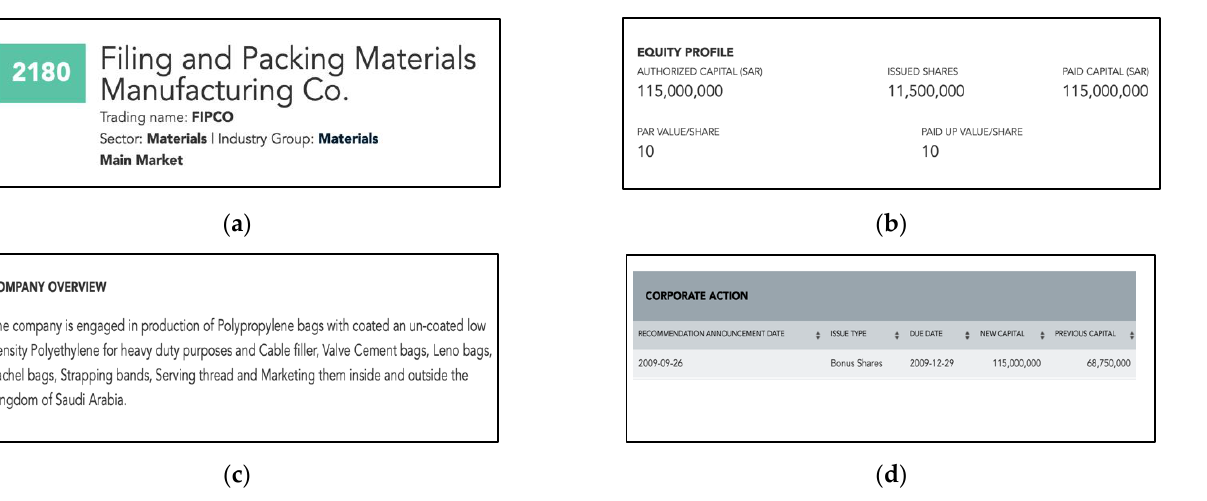
Figure 2. A sample of annual financial results companies release and Tadawul publishes. 3.2.3. Stocks’ Historical Trading Data The historical market data Tadawul’s authority releases (through their EReference data service in [37]) include information about stocks’ trading prices per day since their initial listing. Every instance of the data represents a trading day for a stock in the market. It includes several attribute values, such as stock company name, symbol code (each stock symbol’s unique id), date, stock opening price, stock highest price, stock lowest price, stock closing price, and the volume of shares traded that day. Table 1 shows a sample of the historical trading data Tadawul provides. It is worth mentioning that these data are used to generate some feature values and to facilitate the process of producing the ground- truth labels for our training instances (which we will describe next).